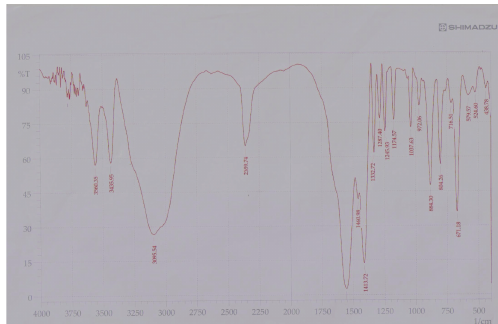
F 1: FT-IR spectra for Mg succinate.